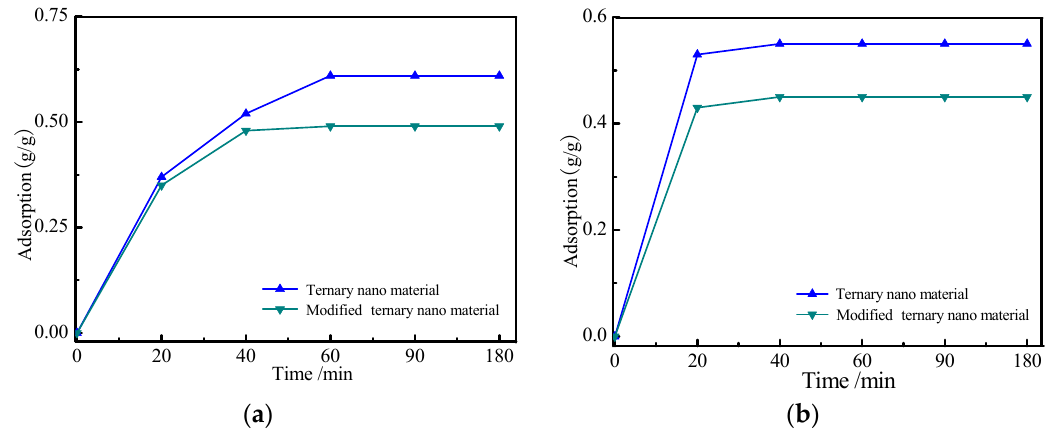
Figure 3. Adsorption curves of nanomaterials against emulsifiers. ( a ) OP10; and ( b ) DNS86.